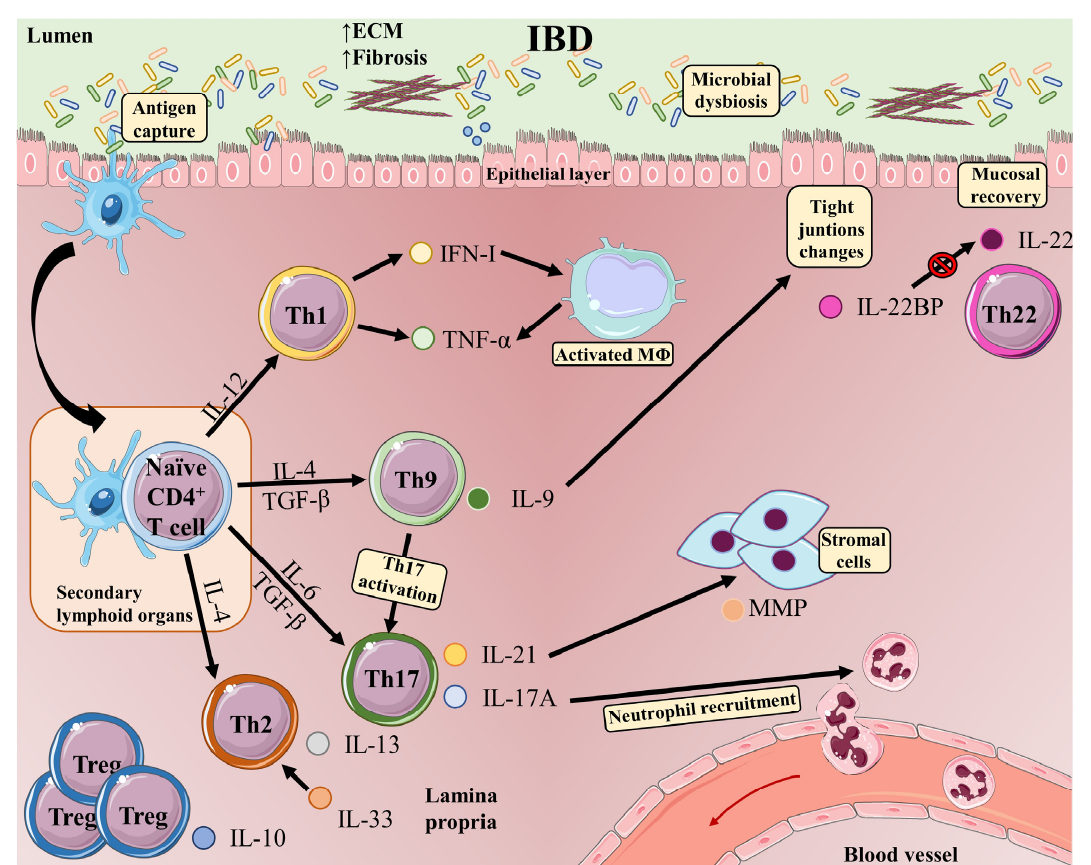
Figure 2. T-cell subsets and functions in the intestinal mucosa in inflammatory bowel disease. The development of IBD is induced by multiple phenomena occurring in the gastrointestinal tract: mi- crobial dysbiosis, disruption of the mucus layer, dysregulation of epithelial tight junctions, defects in the number and function of Paneth cells, and increased intestinal permeability. These events mas-